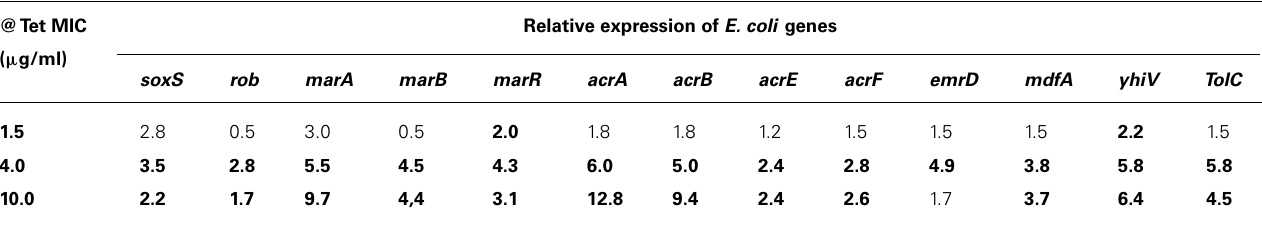
Relative expression of E. coli genes